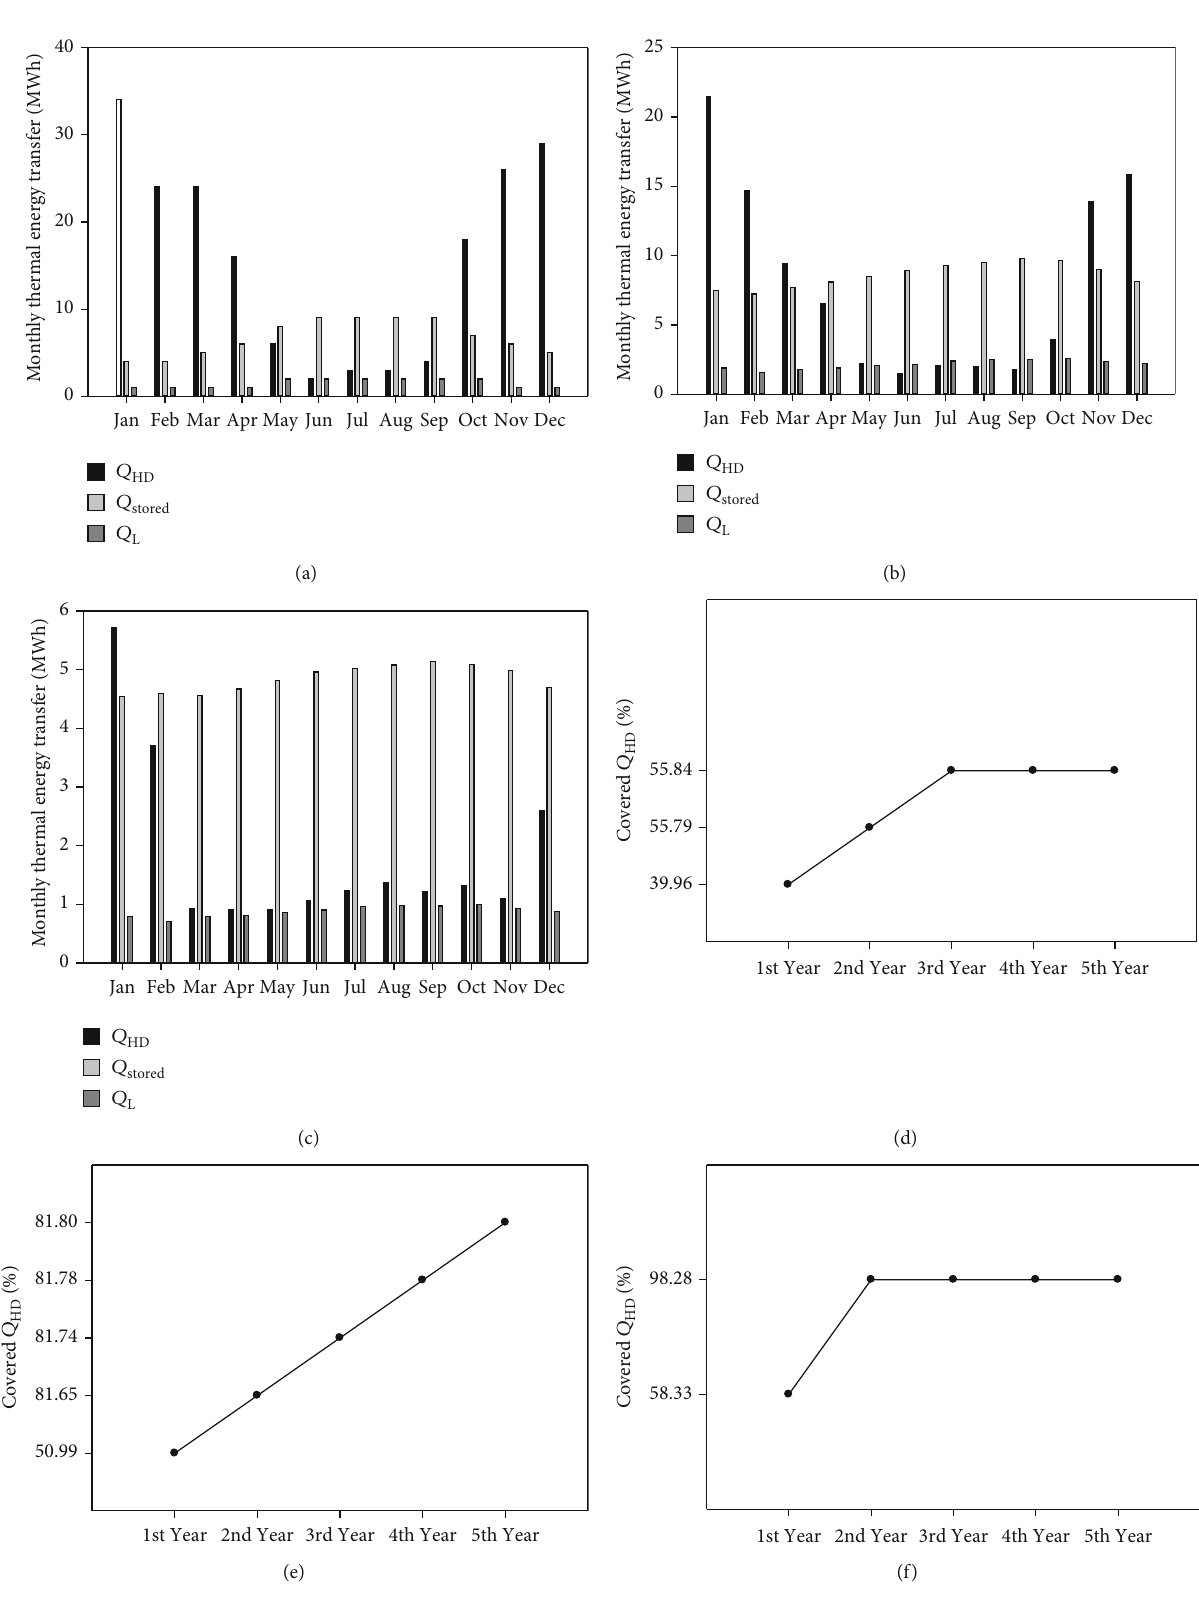
Figure 8: The TRNSYS® simulations ’ fi fth year ’ s STES monthly values for (a) Potsdam, (b) Zarqa, and (c) Doha. Percentage of covered heat demand (kWh) by STES during the fi ve-year span for (d) Potsdam, (e) Zarqa, and (f)